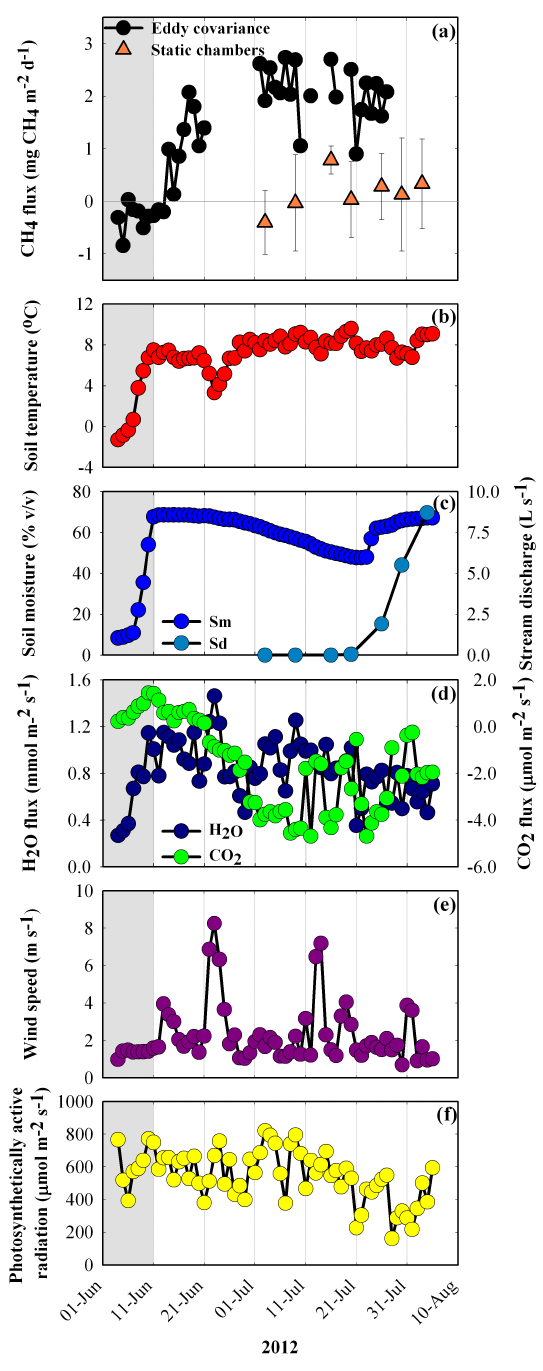
Figure 4. Comparison of mean daily eddy covariance and static chamber CH 4 fluxes (a) at the wetland and several mean daily envi- ronmental variables (b–f) during the 2012 growing season. Shaded bars highlight the period of rapid soil